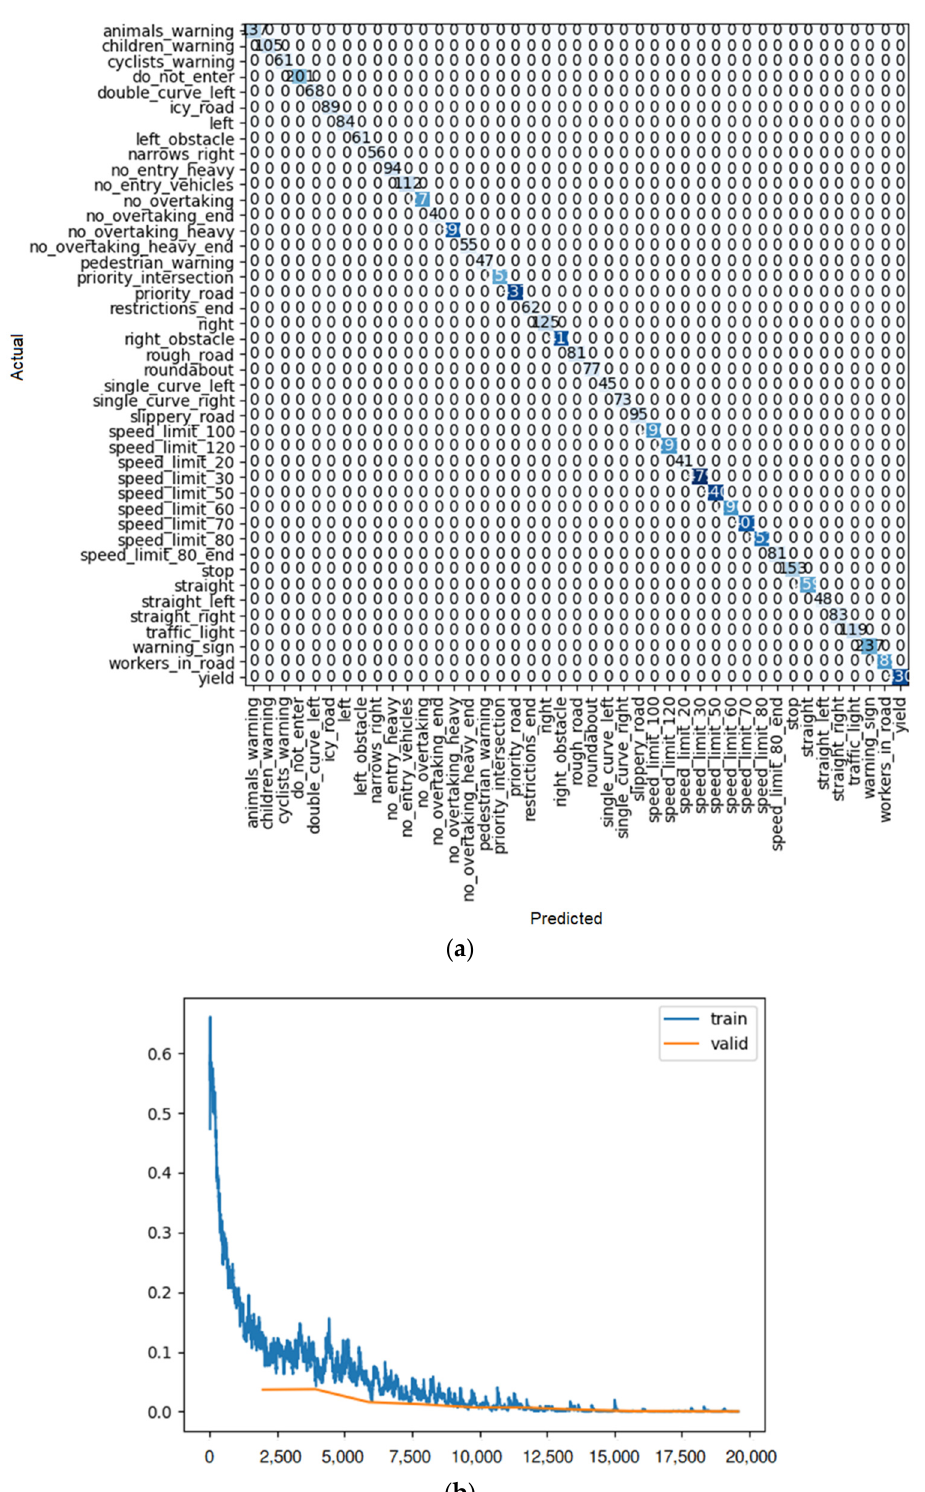
Figure 11. ( a ) Confusion matrix and ( b ) loss rate during training with ResNet 34.